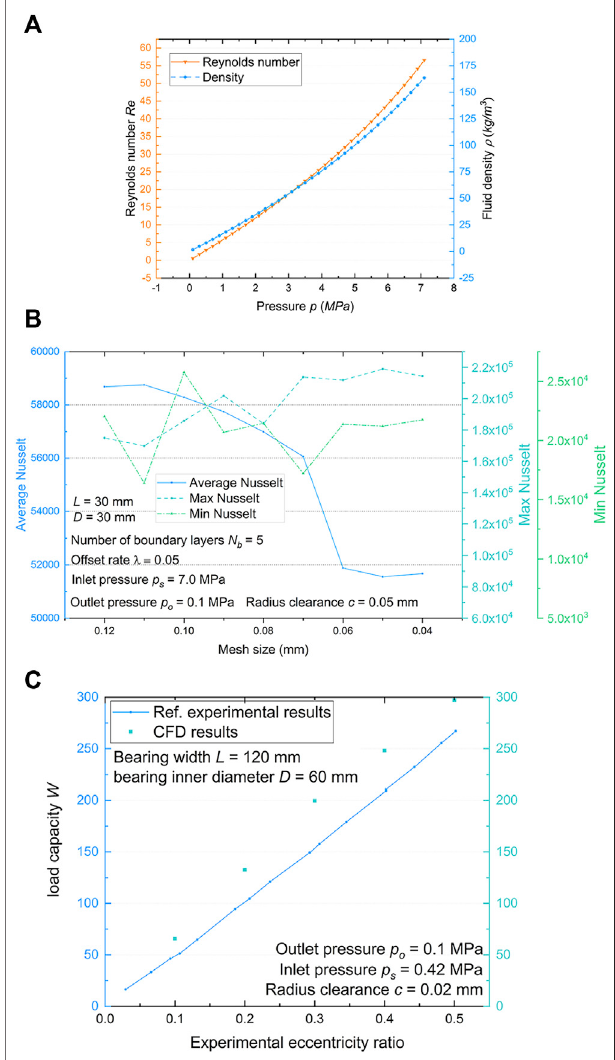
FIGURE 2 | Grid re fi nement and experimental veri fi cation. (A) Reynolds number distribution vs. parameters, (B) Grid independence study for the numerical computation, (C) Experimental data vs. CFD results of load